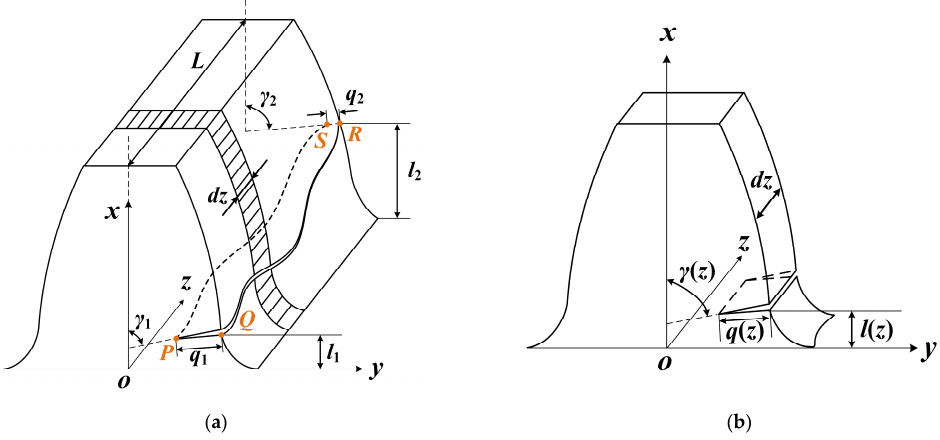
Figure 9. Tooth model with a spatial crack: ( a ) a three-dimensional model; ( b ) a tooth slice.